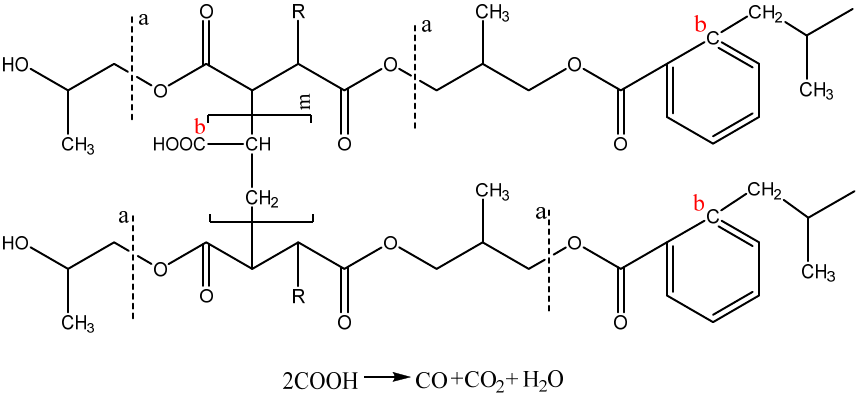
( a )—6.77:93.23 and ( b )—86.67:13.33.